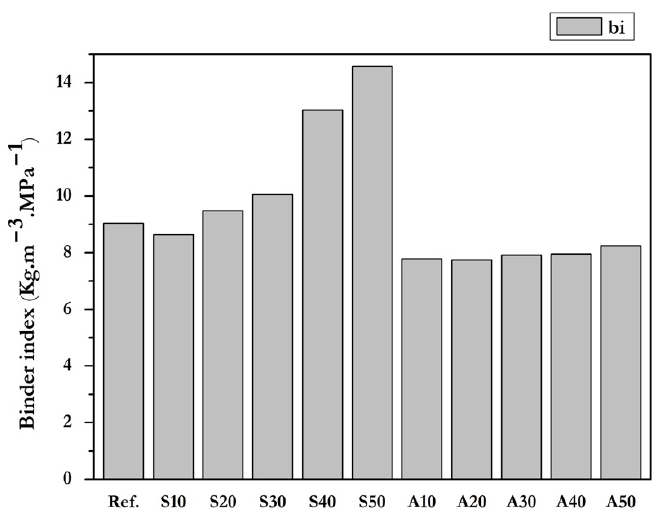
Figure 12. Relationship between carbonation depth and compressive strength.